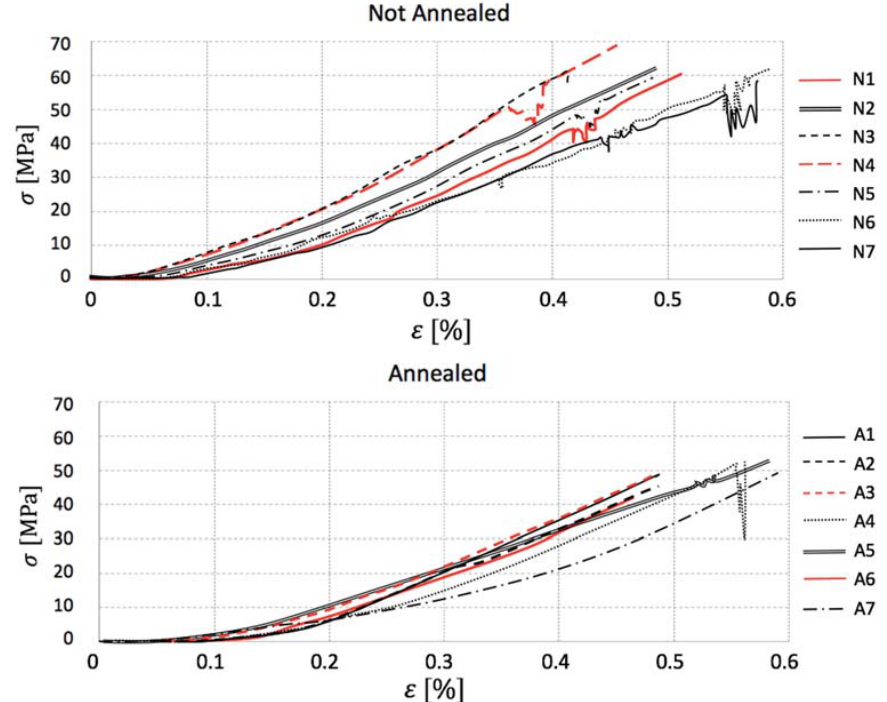
Figure 8. Comparison of bending test stress–strain curves.